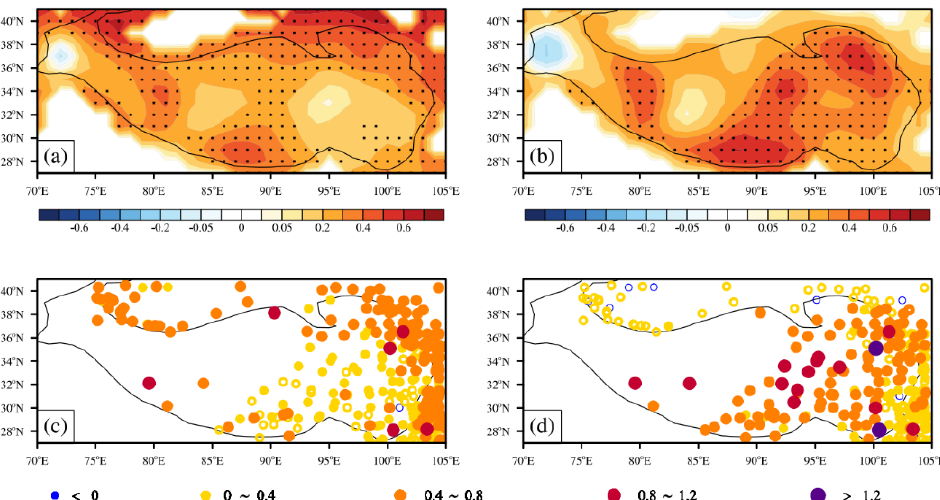
Figure 9. Trends of the 2-m temperature (top, units: K decade − 1 ) from the ERA-Interim reanalysis and surface temperature from observational stations (bottom, units: K decade − 1 ) over the TP during 1979–2017. ( a , c ) are in spring (March–May), while ( b , d ) are in winter (December–February). The black contour denotes the isoline of 3000-m elevation. The dots in ( a , b ) and filled circles in ( c , d ) indicate significant trends at 95% confidence level using the student- t test.